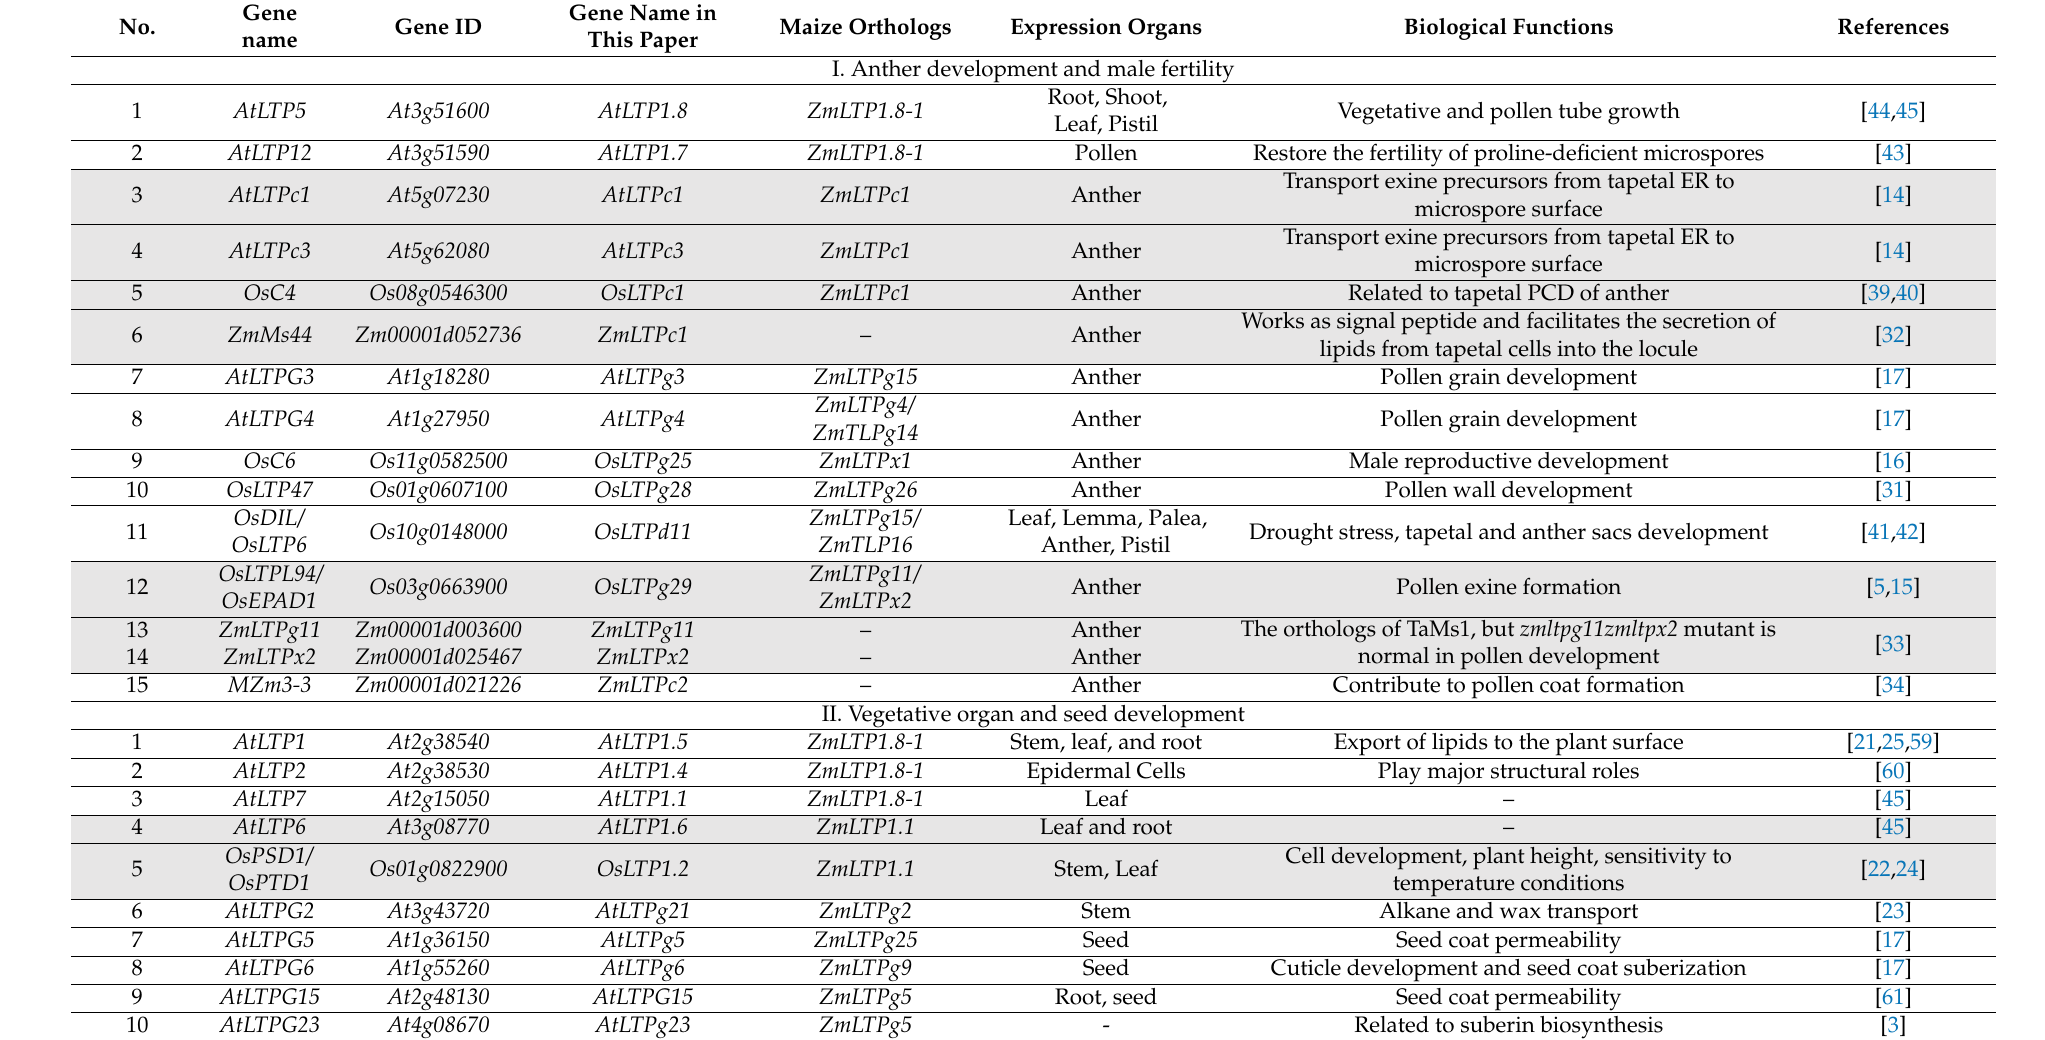
Table 2. Functional classifications of the reported LTP genes in Arabidopsis , rice, and their orthologs in